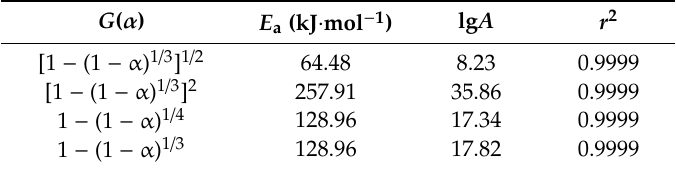
Table 3. The kinetic parameters calculated by the Šatava–Šest á k method for four kinds of higher correlation coe ffi cients reaction models by lg G ( α )-1 / T fitting